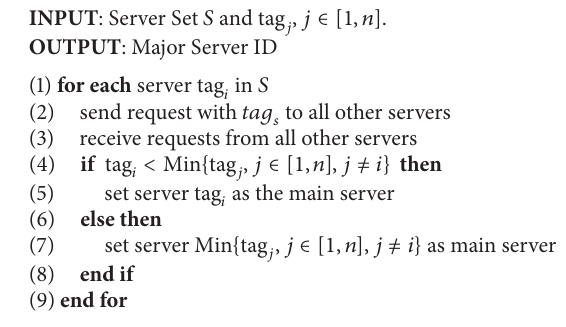
Algorithm 1: Algorithm to elect the major